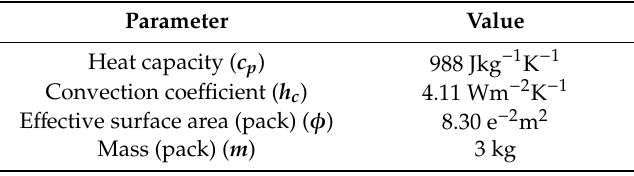
Table 4. Parameters of the designed thermal model.